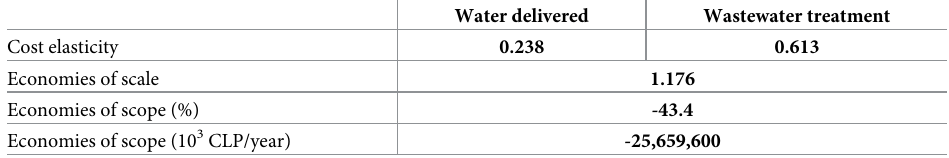
Table 3. Cost elasticities, economies of scale and scope for the average Chilean water